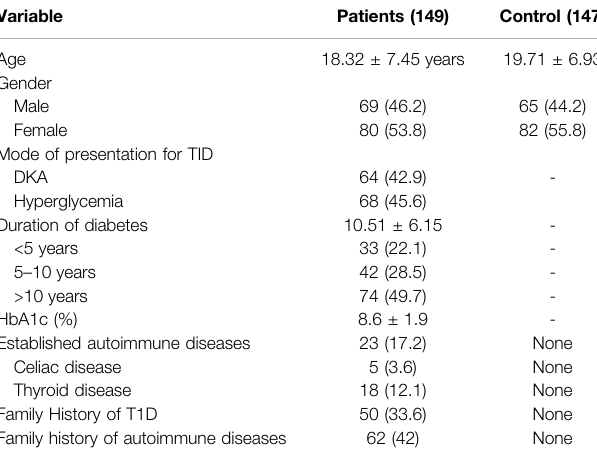
TABLE 1 | Clinical and demographic characteristics of the study population.